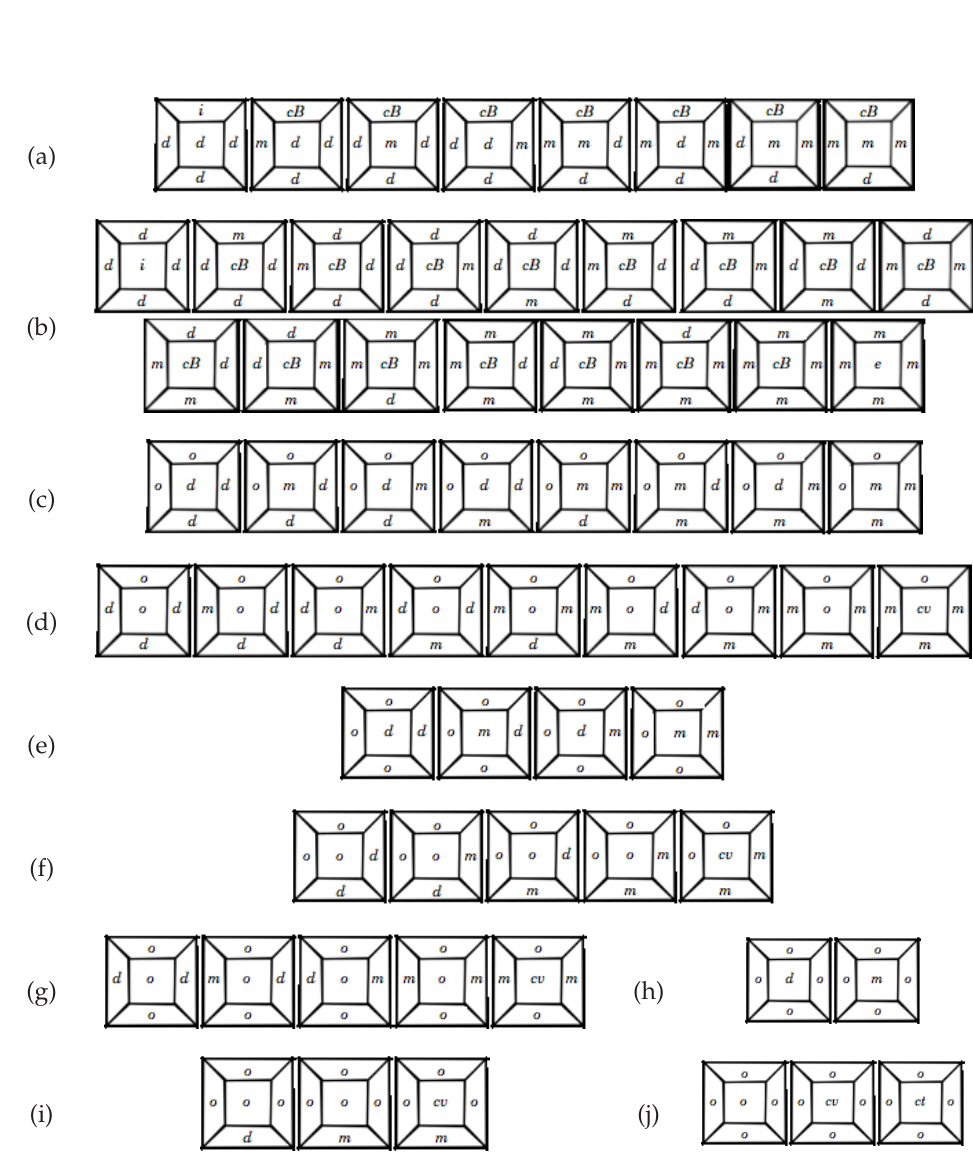
Figure 16: Topological augmentation applied to the peripheral direction relations. Each group (a–j) represents the members of an exemplar from the ten congruence classes. Each of these symbols (and rotated versions) can be used to provide additional context to pe- ripheral direction relations. The symbols used to refer to each qualitative partition relation correspond to those abbreviations for the 9 -intersection relations given in Figure